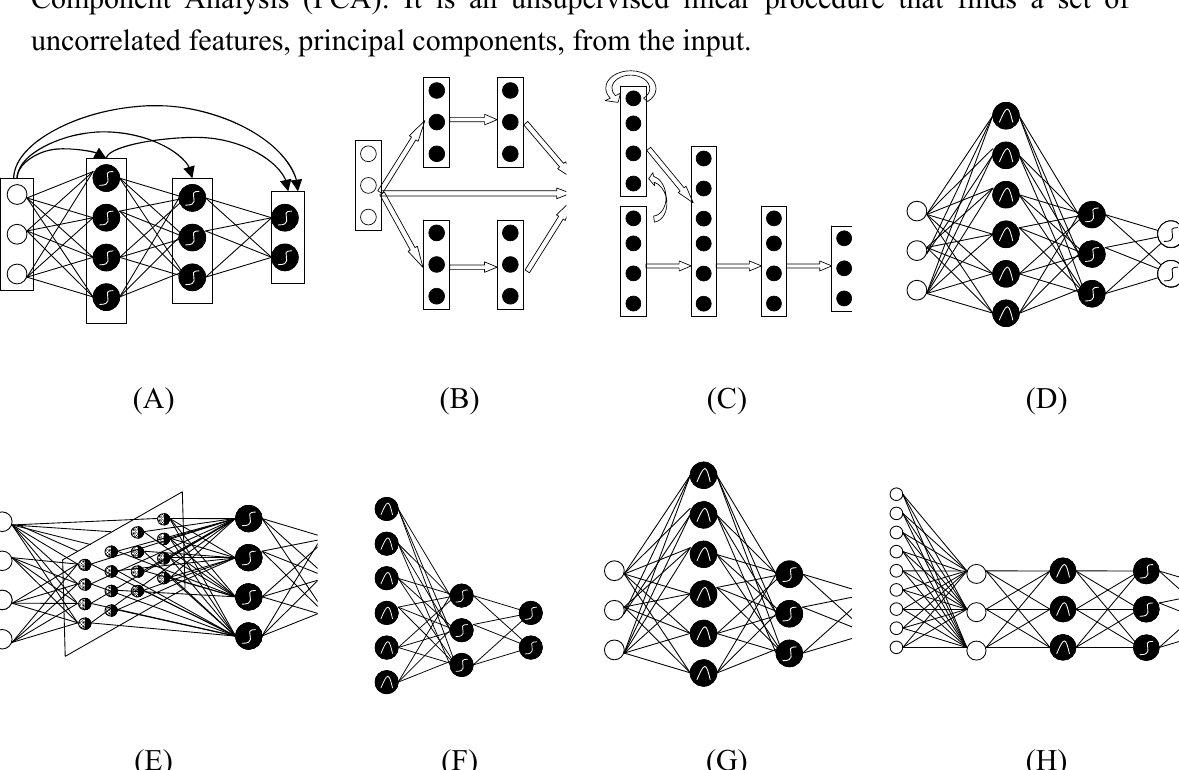
Figure 3. Schematic diagram of eight cloud classifiers: in general the left layer is input layer; the right layer is output layer; and the middle ones are hidden layers. Note that the white circles in the left are input neurons, and in the right are output ones. Black circles are neurons in hidden layer. Lines around circles and arrows between layers show the data flow between neuron and layers respectively. Curves in circles show the transfer